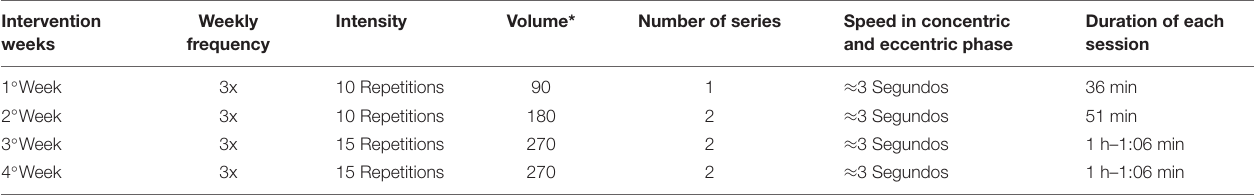
Duration of each and eccentric phase